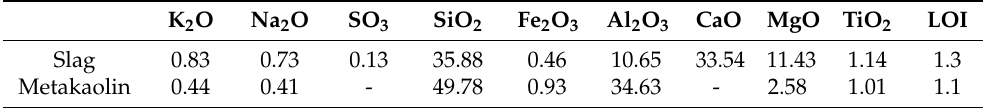
Table 1. Chemical composition of slag and